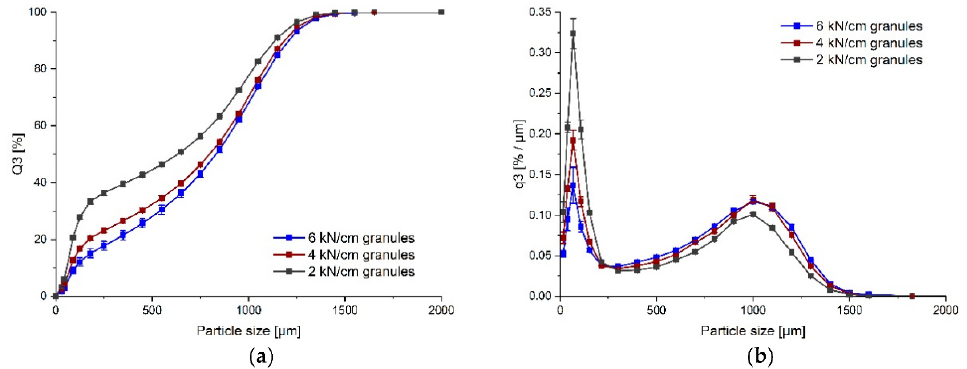
Figure 4. ( a ) Cumulative and ( b ) density particle size distribution (PSD) of granules (F 10) obtained at different specific compaction forces (2, 4, and 6 kN/cm); mean ± SD, n = 3.